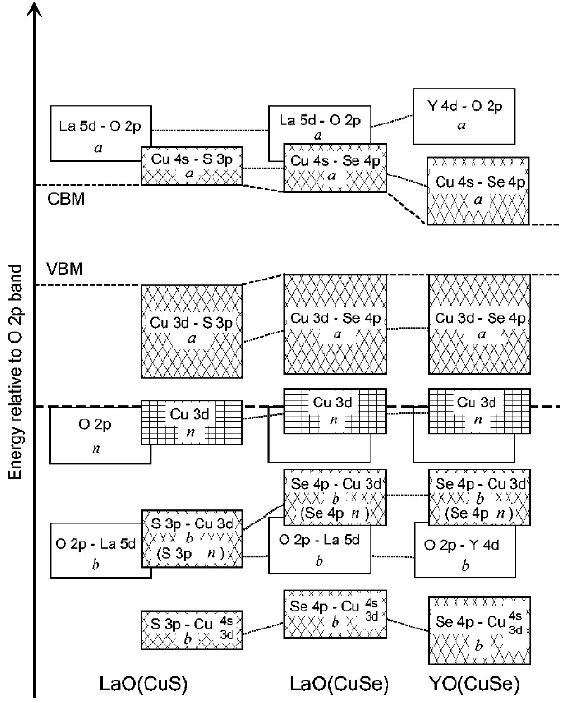
Figure 8. Schematic diagram of the band structures of LaCuOS, LaCuOSe, and YOCuSe from the first-principle calculation. Reproduced with permission from Ref. [178]. Copyright 2007 AIP Publishing.